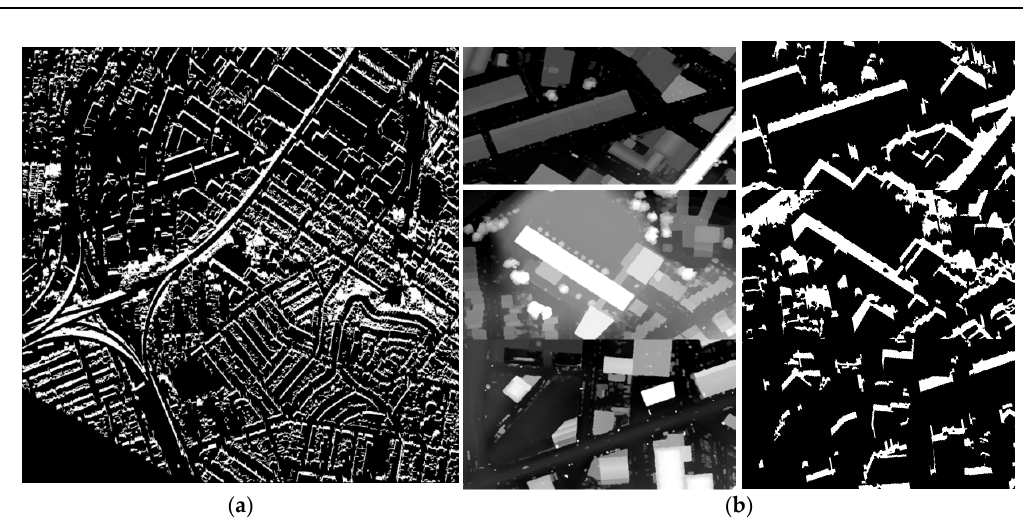
Figure 10. The shadow map extracted from the raster LiDAR data for the sample dataset: ( a ) Result of the overall application (white regions are shadows); ( b ) Enlarging the result of applying the algorithm on three regions alongside the LiDAR data.